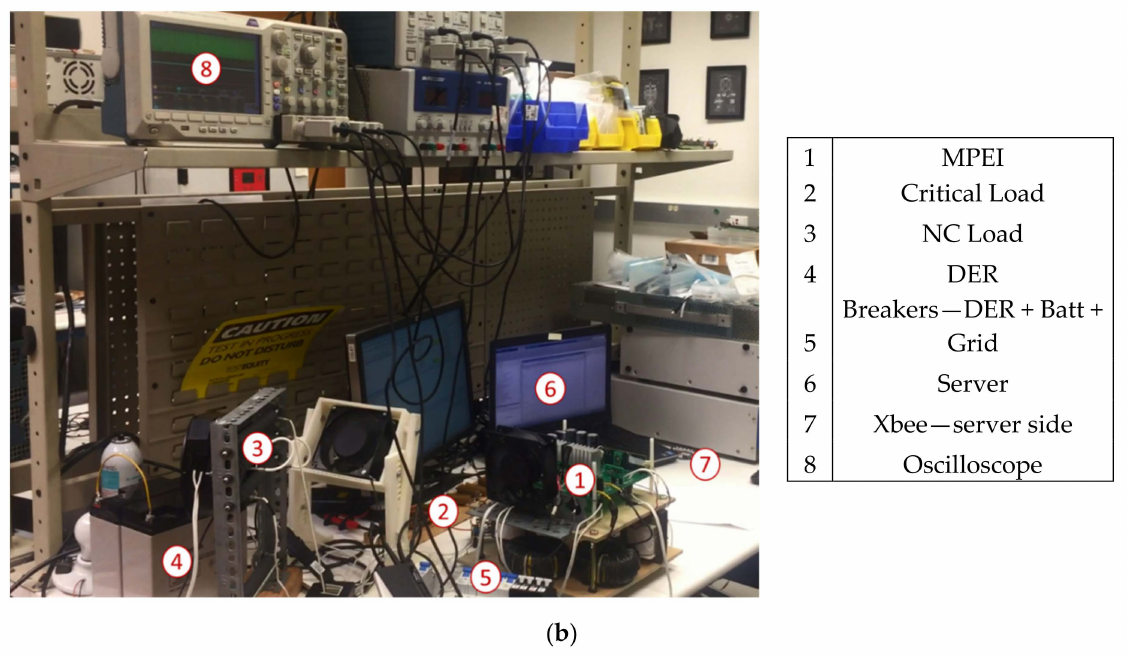
Figure 8. ( a ). MPEI board description. ( b ). Experimental setup with MPEI and Q-learning-based EMS.